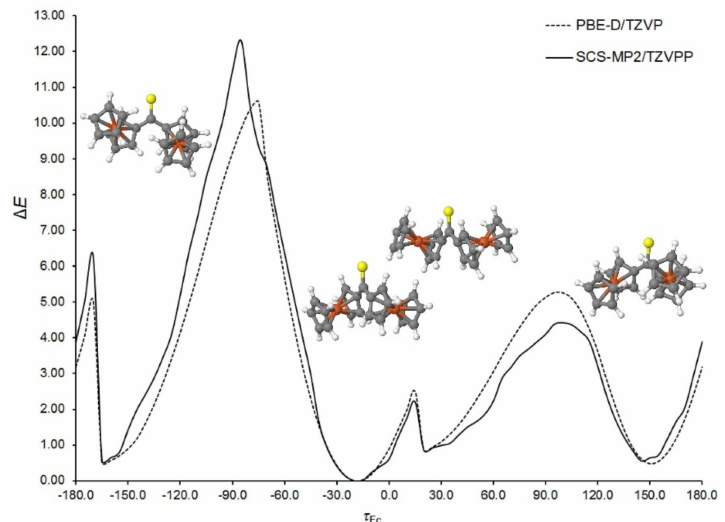
Figure 2. Energy of an isolated Fc 2 CS molecule as a function of the dihedral angle describing the rotation of Fc-group ( τ Fc , in ◦ ). The energy ( ∆ E , in kcal mol − 1 ) is expressed relative to its lowest value at each level of theory. The schematic illustrations of the PBE-D / TZVP geometries corresponding to the minima of ∆ E are also presented.